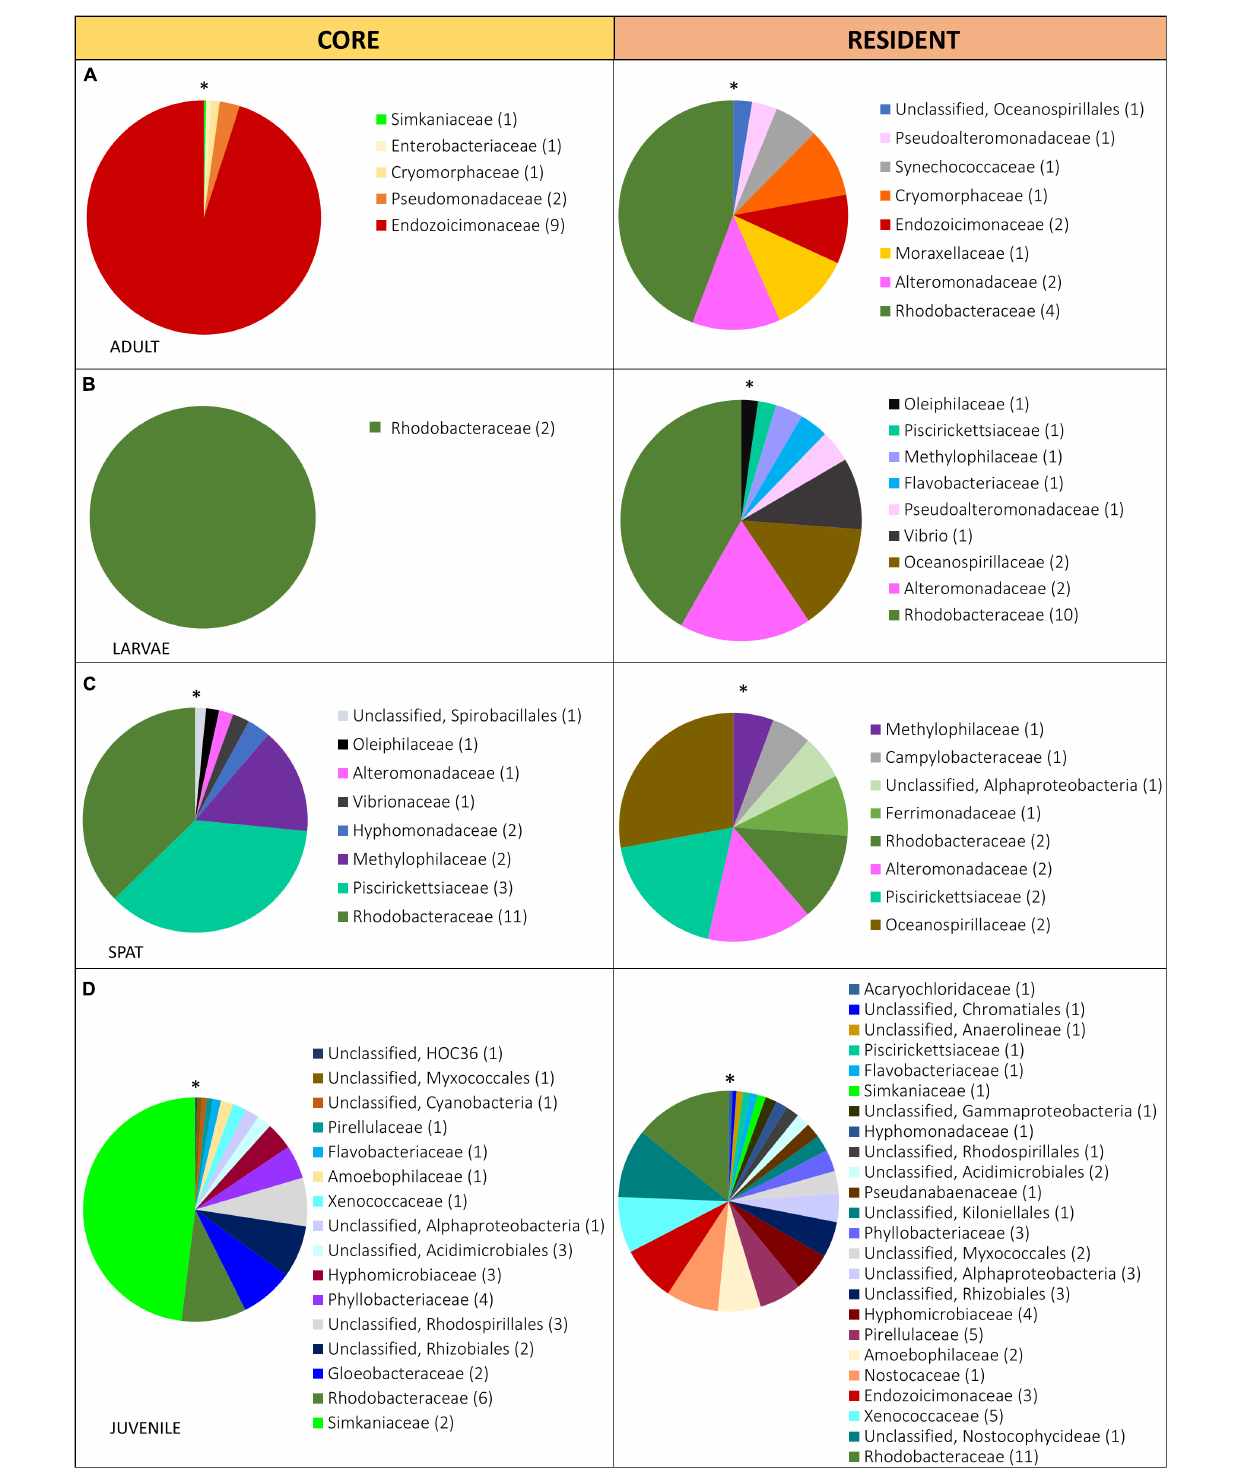
Frontiers in Microbiology |